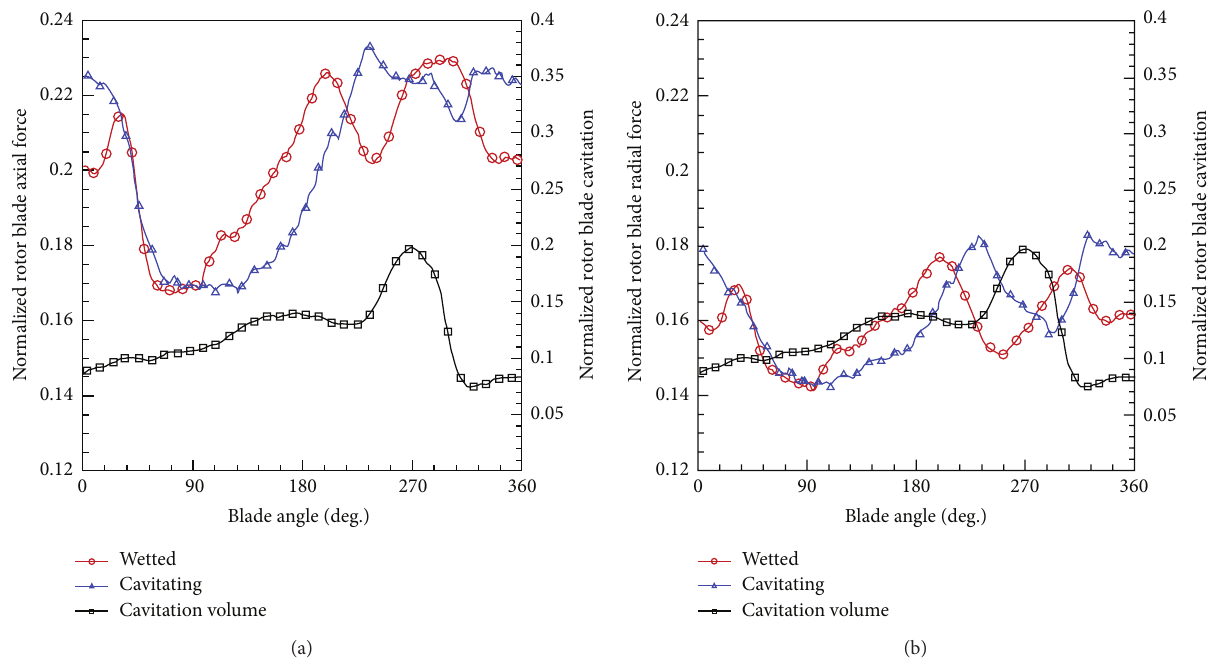
Figure 15: Normalized unsteady wetted and cavitating axial forces (a) and radial forces (b), along with the normalized fluid cavitation volume on a rotor blade (blade-1) along one revolution. Rotating blade-fixed coordinate